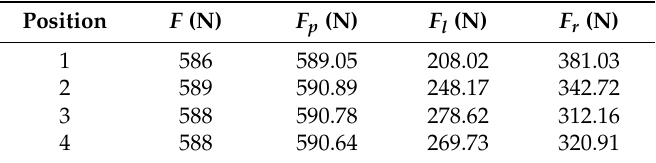
Figure 18. Comparison of values measured by the force plate and proposed six-dimensional sensor in application experiments.